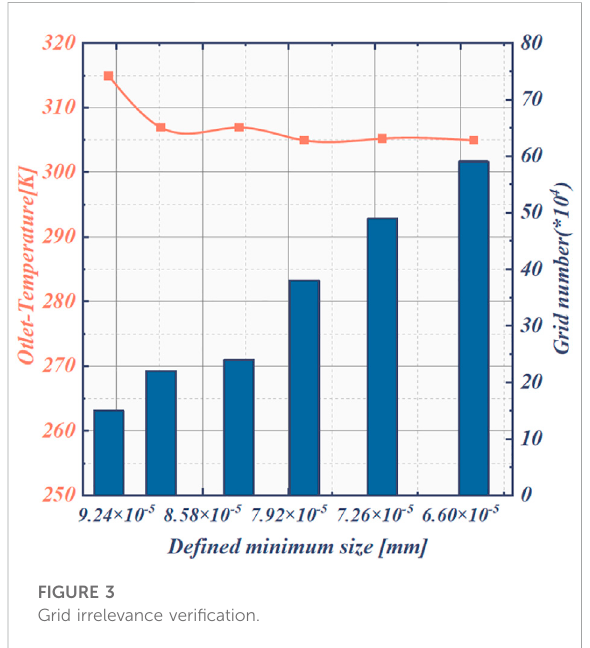
FIGURE 3 Grid irrelevance veri fi